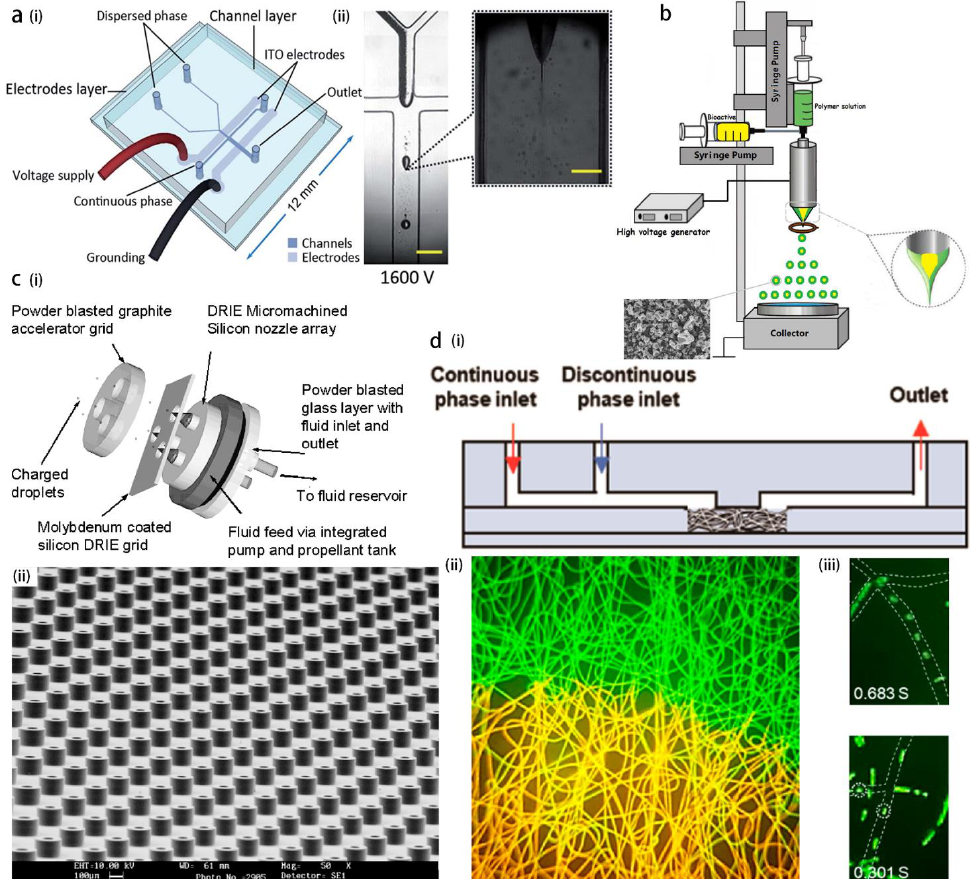
Figure 5. ( a ) Electrospray of co-flowing bi-disperse phases for the formation of Janus droplets, the sketch of the device ( i ) and the experimental image ( ii ). Reproduced from [62], copyright 2011, Royal Society of Chemistry. ( b ) The device for electrospray of co-axial fluids for the formation of core-shell droplets, reproduced from [50], copyright 2021, Elsevier. ( c ) Electrospray device as the colloidal thruster for accurate position regulation of aero-crafts, the device ( i ) and the arrays of silicon nozzles ( ii ). Reproduced from [65], copyright 2006, AIAA. ( d ) Electrospun nanofibers as the template of a porous media for submicron droplets generation. The matrix made from the electrospun fibers is inserted into a PDMS channel ( i ), both continuous and disperse phases flow through the porous media, with their interface shown as the boundary between yellow and green ( ii ), submicron droplets of disperse phase are formed in the pores via T-junction and Y-junction modes ( iii ). Reproduced from [67], copyright 2022, American Chemical Society.